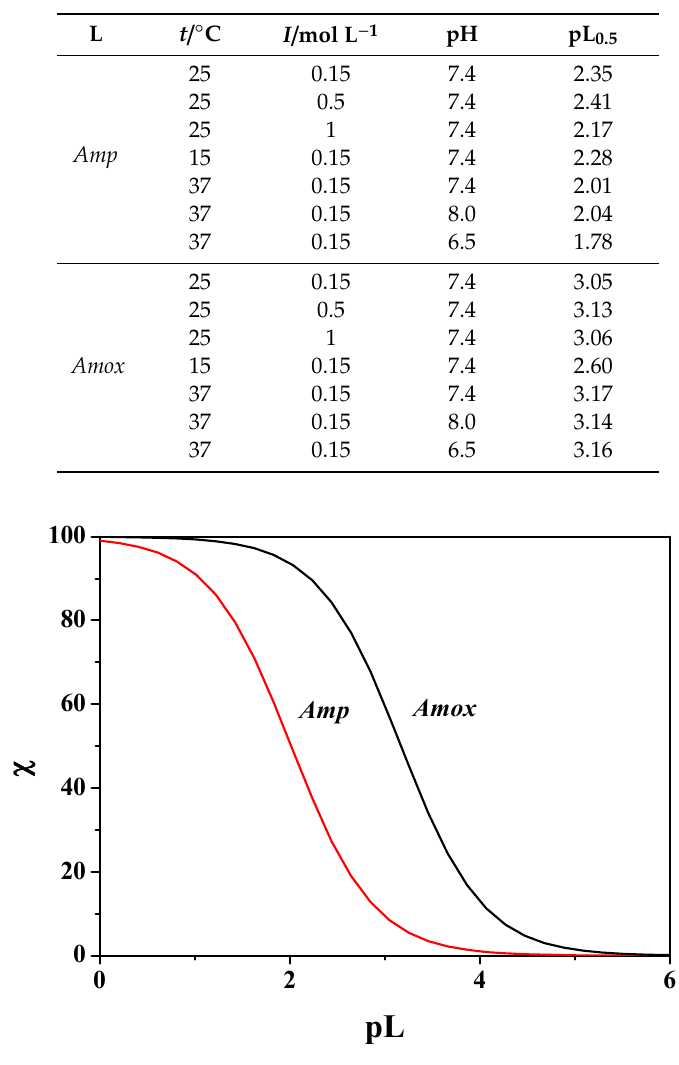
Figure 11. Sum of the fractions of Mn 2 + - Amp (in red), Mn 2 + - Amox (in black) species at pH = 7.4, t = 37 °C, I = 0.15 mol L − 1 in NaCl.